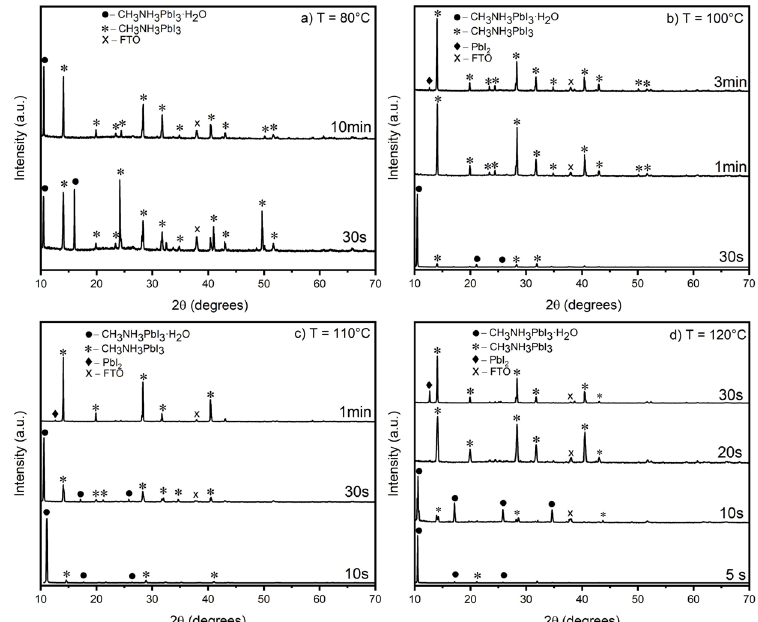
Figure 1. XRD patterns of the perovskite 24h-films fabricated via spray deposition at different temperatures and annealing times: a) 80 o C; b) 100 o C; c) 110 o C; d) 120 o